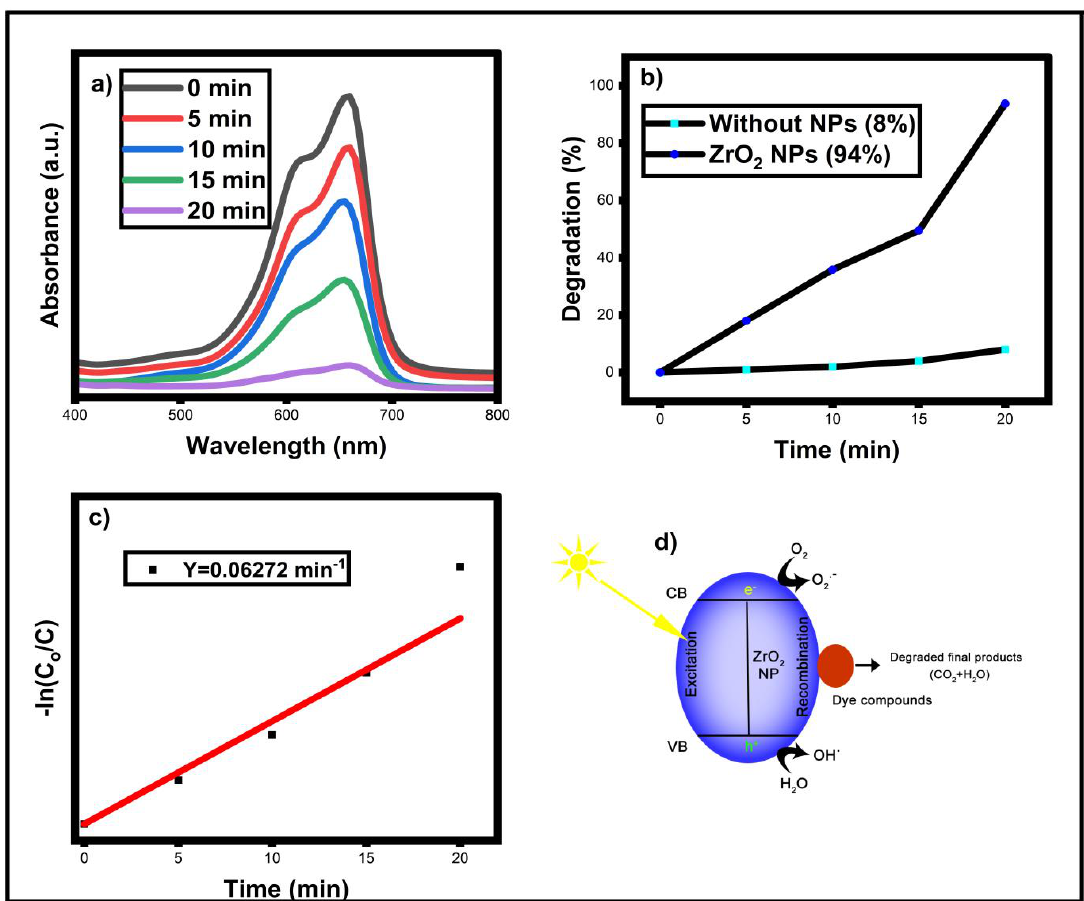
Figure 7. Photocatalytic degradation absorbance spectrum ( a ), degradation efficiency spectrum ( b ), pseudo-first-order kinetic spectrum ( c ), and degradation mechanism ( d ) of biosynthesized ZrO 2 NPs.